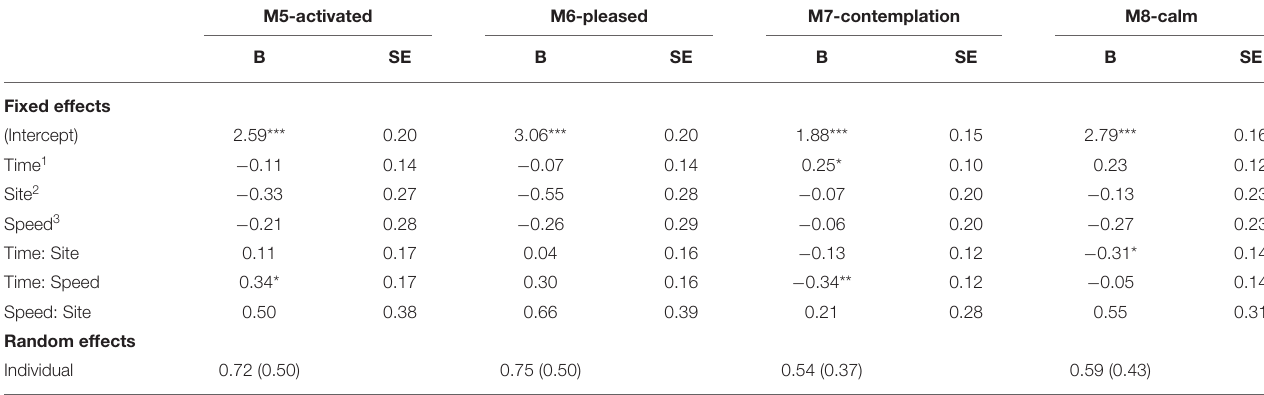
TABLE 4 | Multilevel modeling results for the effects of walking conditions on the positive